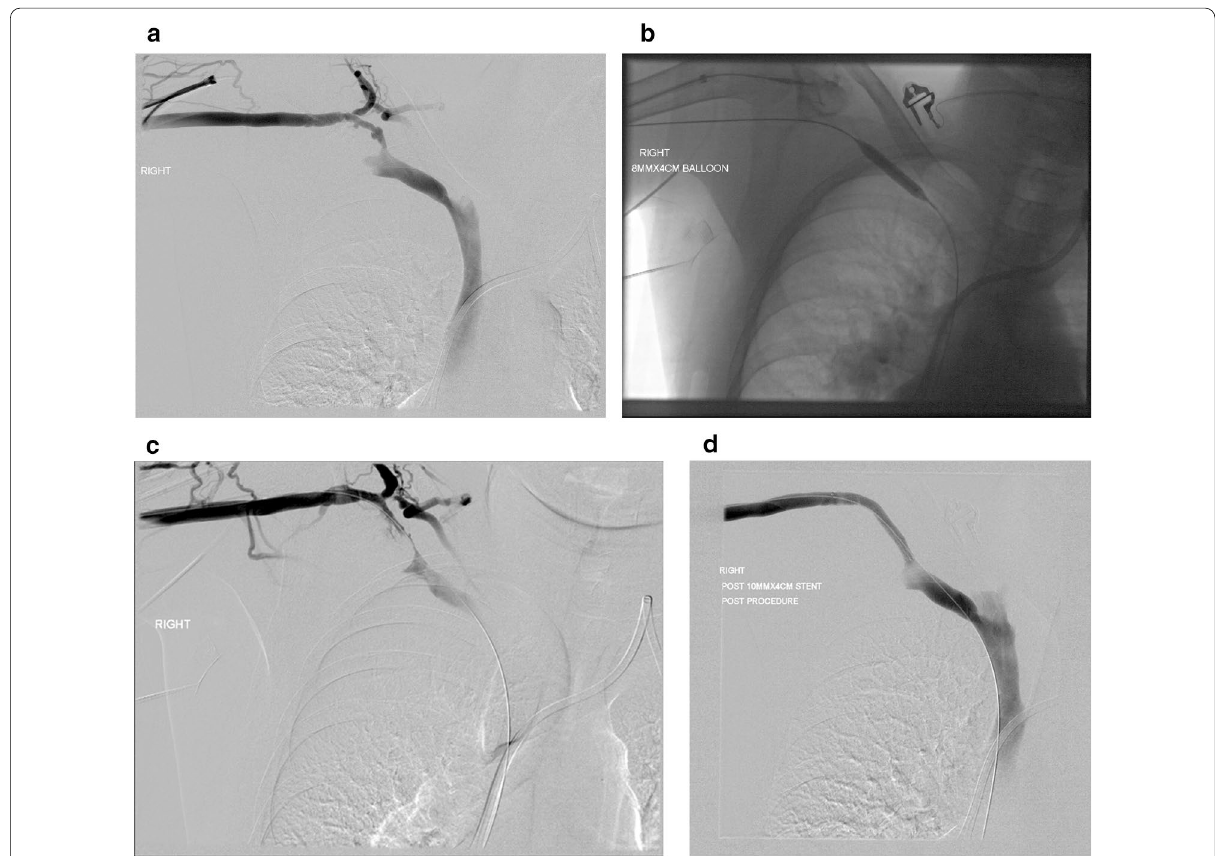
Fig. 2 a Antegrade diagnostic venogram in right AVF showing tight stenosis at the terminal arch. b Angioplasty at the terminal arch using 8 mm 4 cm balloon. c Post-angioplasty venogram showing no significant improvement of the stenosis at the terminal arch. d Deployment of × 10 mm 4 cm self-expandable stent at the terminal arch with completion venogram showing no significant residual ×